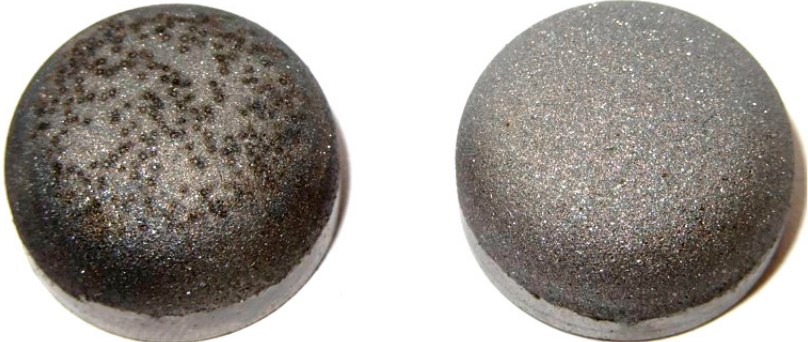
Figure 3. Plug ‐ type contact with diameter 19 and 10 mm length in new ( right ) and worn condition after test ( left ). The surface has a biradial shape with a radius of 5 mm at the side and 20 mm at the tip,